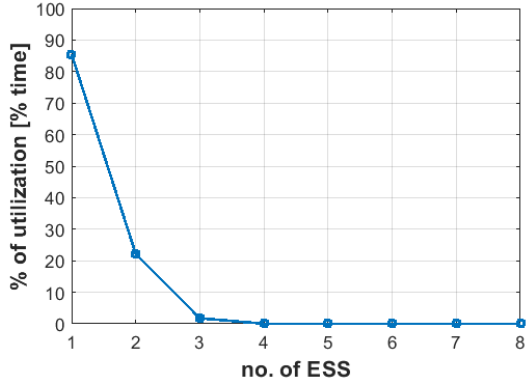
Figure 15. Percentage of utilisation time per each FESS module of the ESS system.